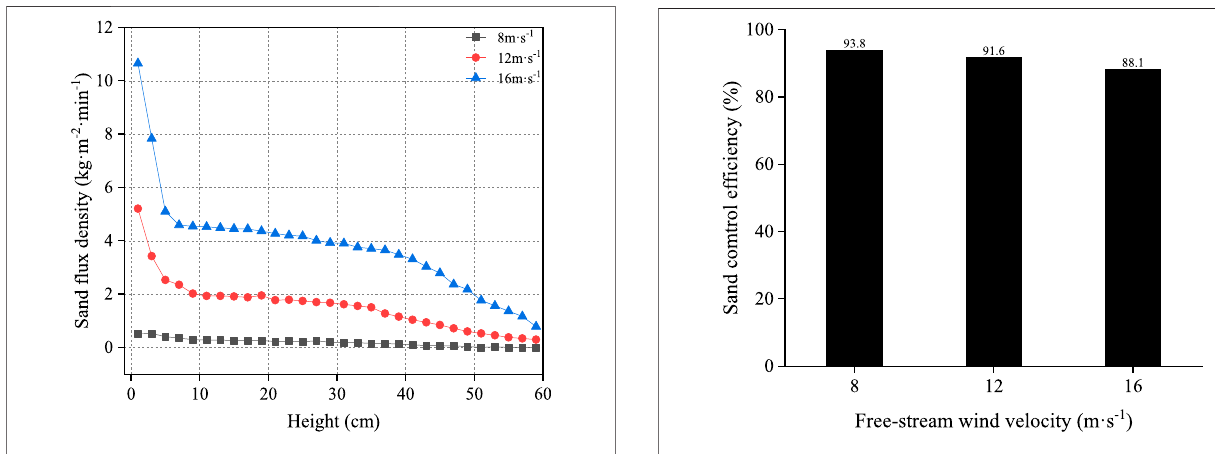
Frontiers in Environmental Science |